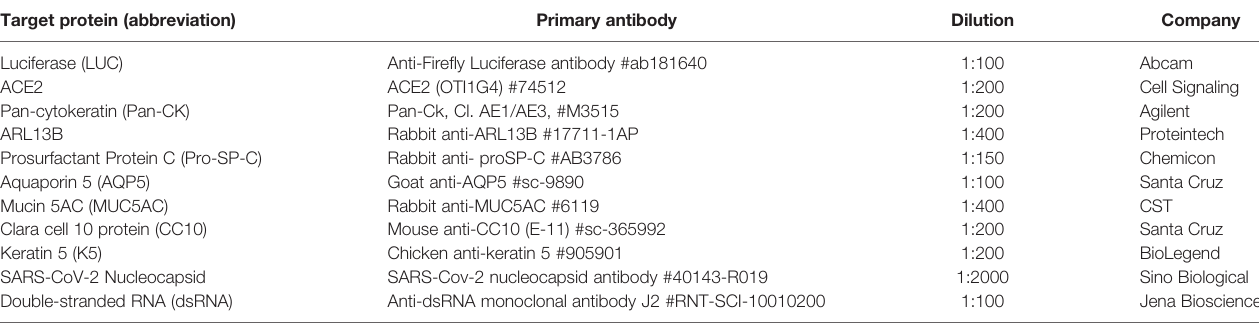
TABLE 3 | The product information and dilution of primary used to detect the various target epitopes in this study. Target protein (abbreviation)